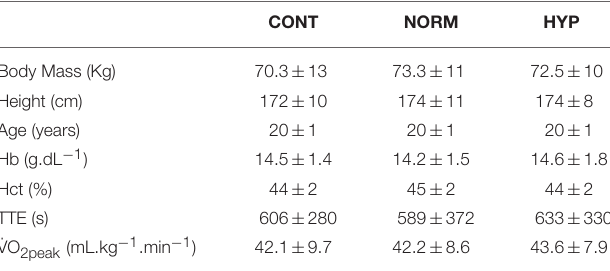
TABLE 1 | Participant baseline values for anthropometric and aerobic capacity measures. CONT